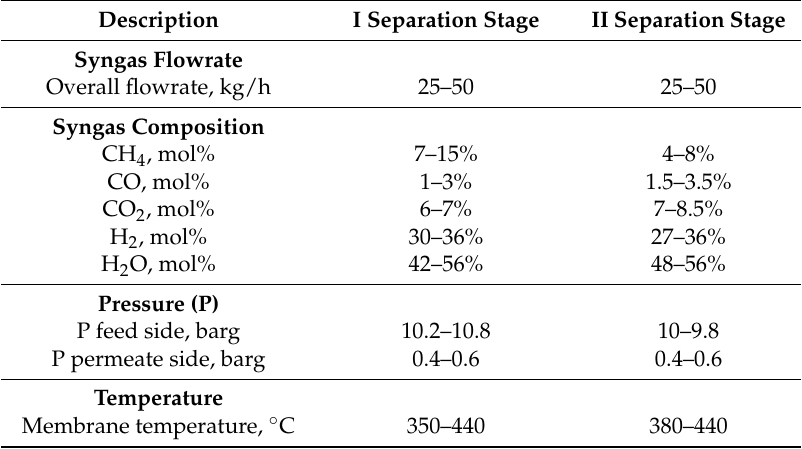
Table 3. Main operating conditions for two-stage reaction and separation configuration.